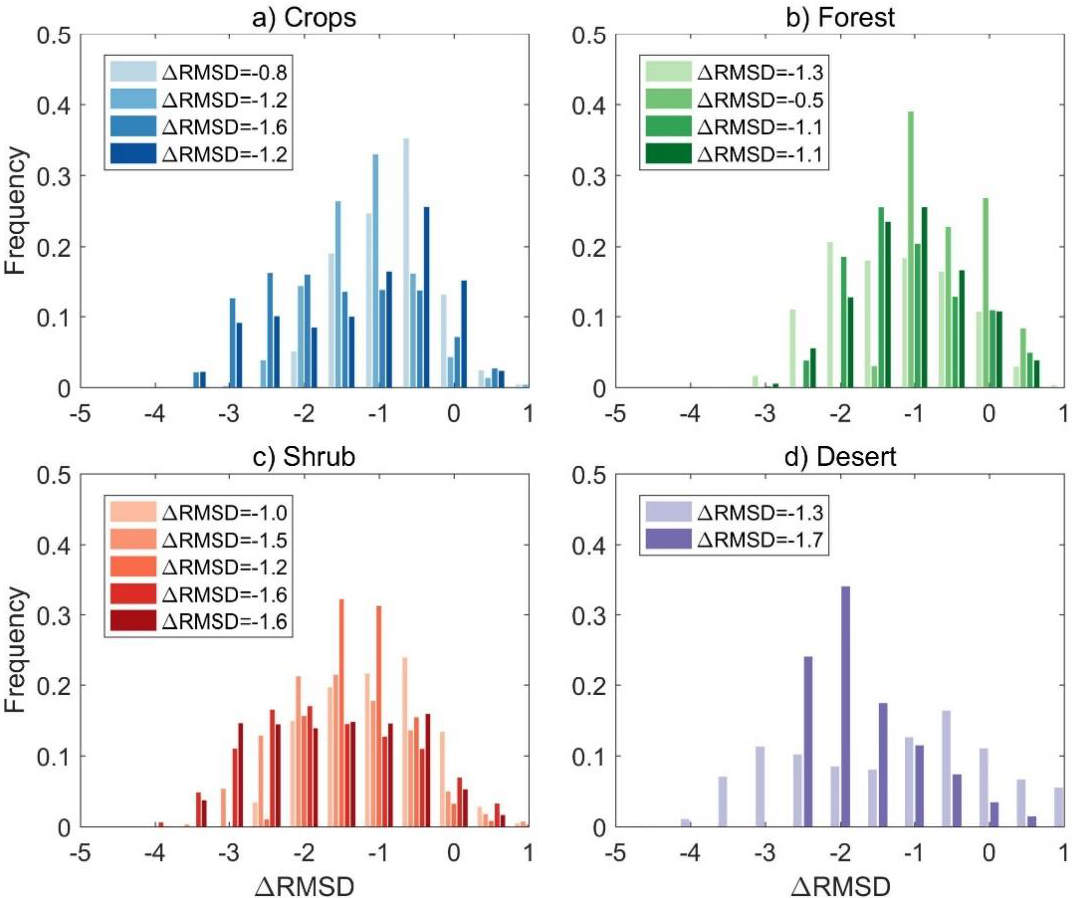
Figure 7. Distributions of the variation of the daytime root mean square differences ( ∆ RMSD) between SEVIRI and MODIS (in K) after applying the angular correction of the Kernel-Hotspot model, for each cluster within each land cover type: ( a ) crops, ( b ) forest, ( c ) shrub, and ( d ) desert. Colors correspond to the color bar of Figure 1. The legend shows the average ∆ RMSD for each cluster.